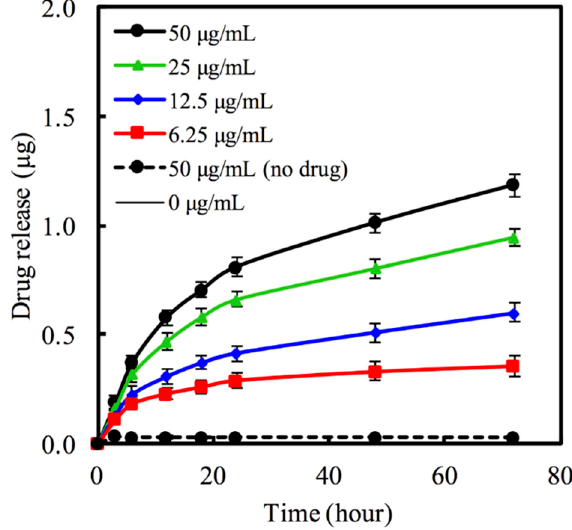
Figure 2. Release amount of hinokitiol from MCS nanoparticles in PBS (pH 7.4) at 37 °C.